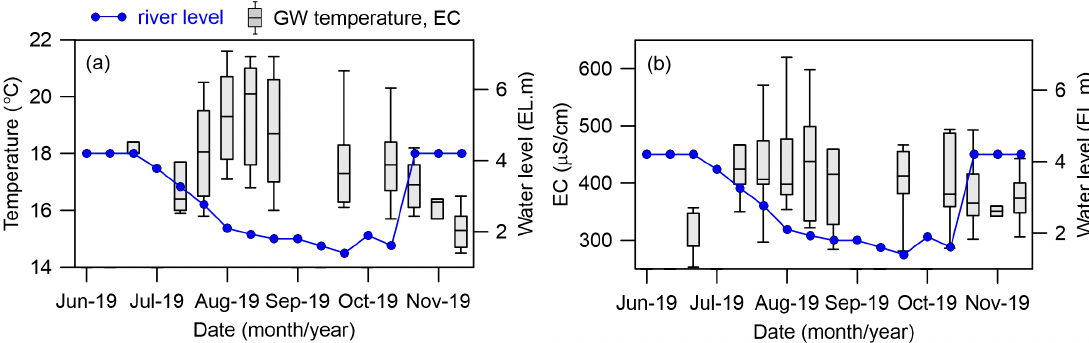
Figure 8. Changes in ( a ) groundwater temperature and ( b ) Electrical conductivity (EC) (box-whisker plots) with the river level variation (point) during weir operation.